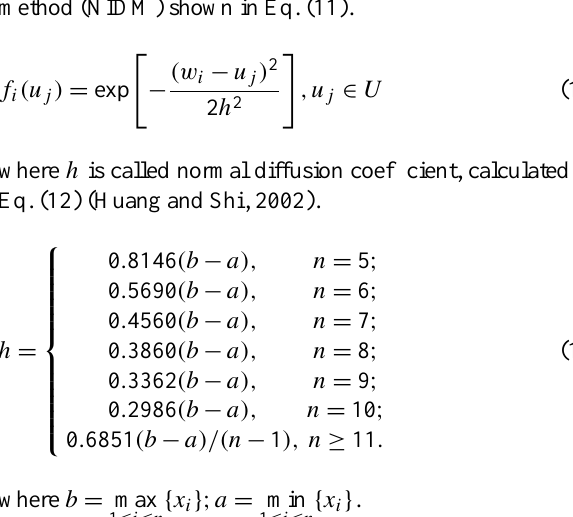
Table 2. Scale preferences used in the pairwise comparison